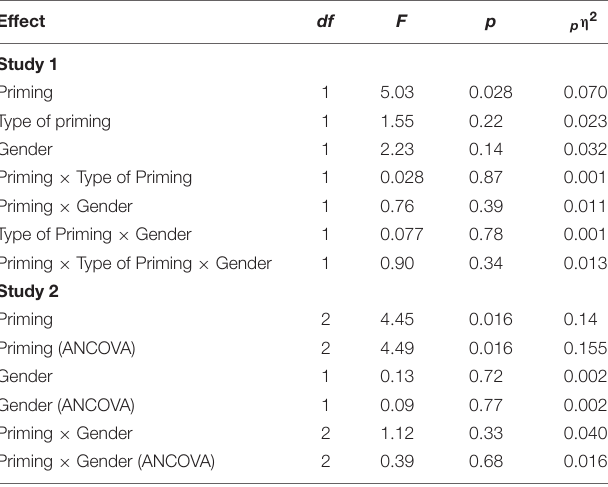
TABLE 1 | Analysis of variance and analysis of covariance for distance perception accuracy in Study 1 and Study 2.